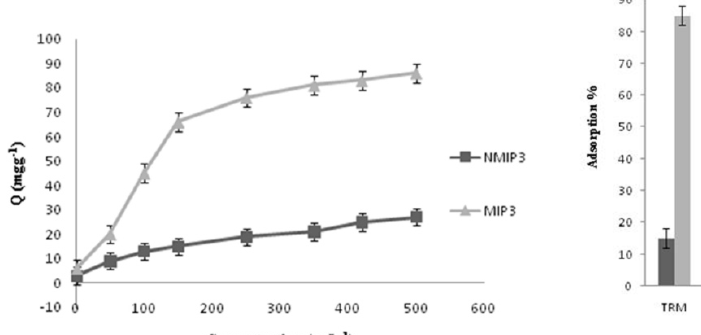
Figure 11. Adsorption of tramadol (TRM), diphenhydramine (DPH), dextromethorphane (DXM), pseudoephedrine (PSE), hydroxyzine (HXZ) and cetrizine (CTZ) with MIP NMIP